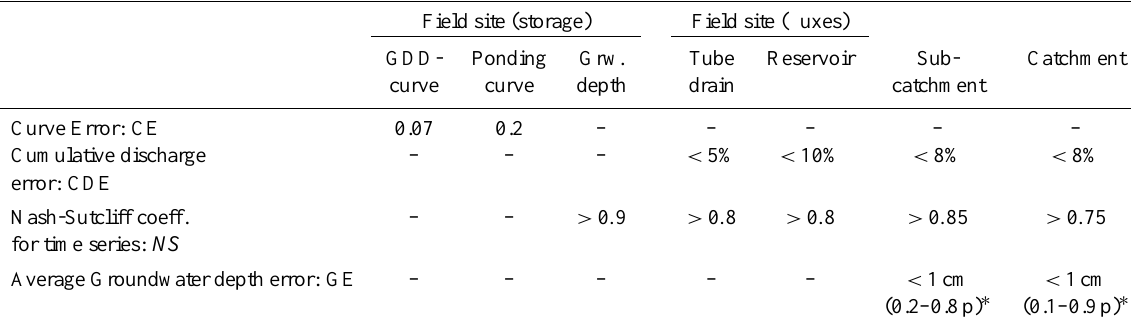
Table 3. The cutoff criteria for behavioral model runs. Model runs are assigned behavioral when they meet to all “goodness of fit” criteria. Expressions for the error terms are given in Appendix